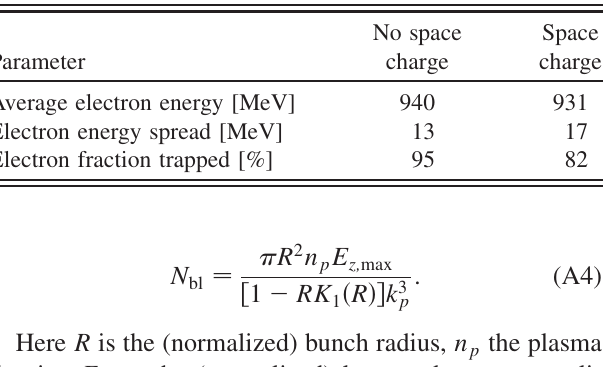
TABLE VII. Effect of space charge on the parameters of accelerated electron bunches when injecting 300 fs in front of the laser pulse with a 0 ¼ 1 : 02